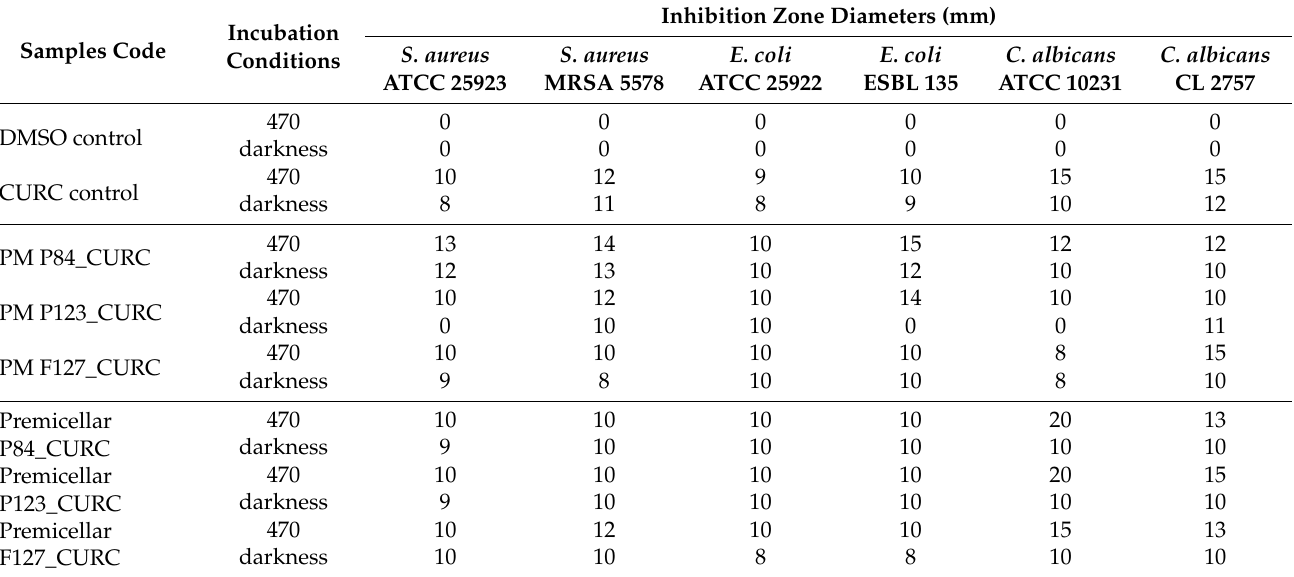
Table 5. The diameter values of the inhibition zone expressed by the tested samples that contain Pluronic and curcumin